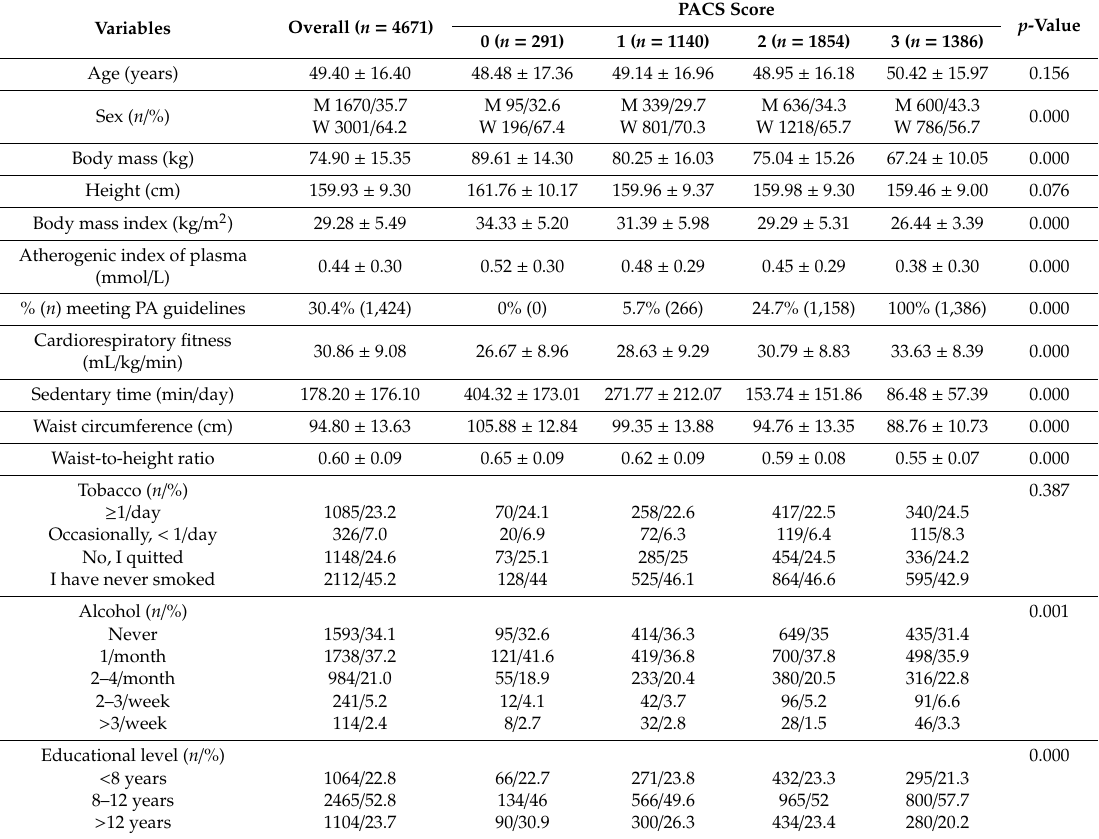
Table 1. Characteristics of the participants as divided by the PACS score, Chilean national health survey 2016–2017 ( n =